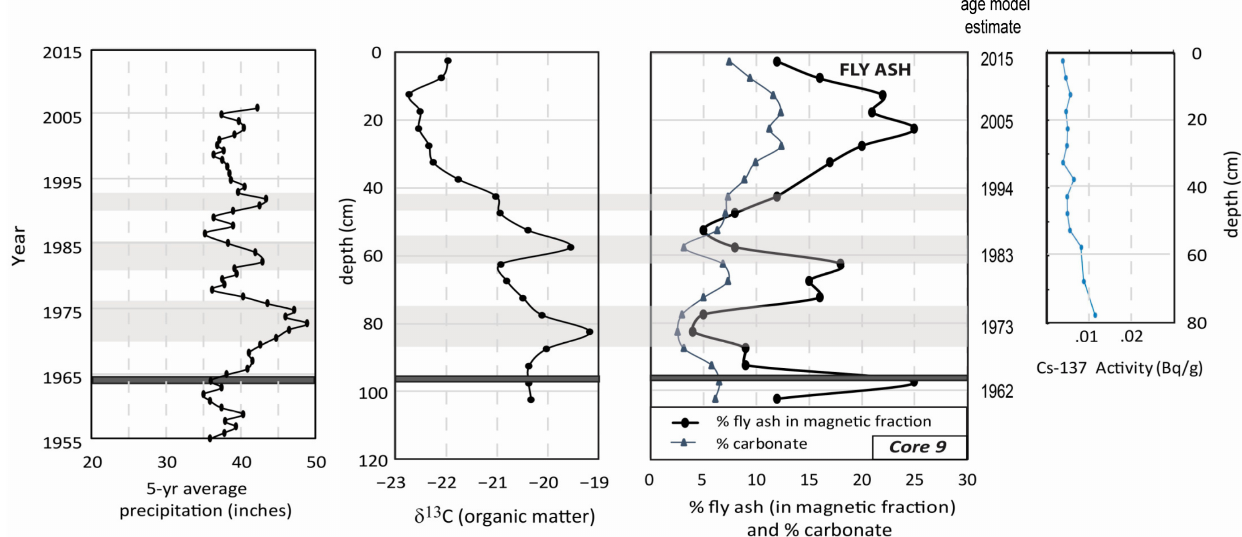
Figure 9. Lake Decatur Core 9: comparison of records of magnetic fly ash, carbonate content, δ 13 C, 137 Cs, and particle